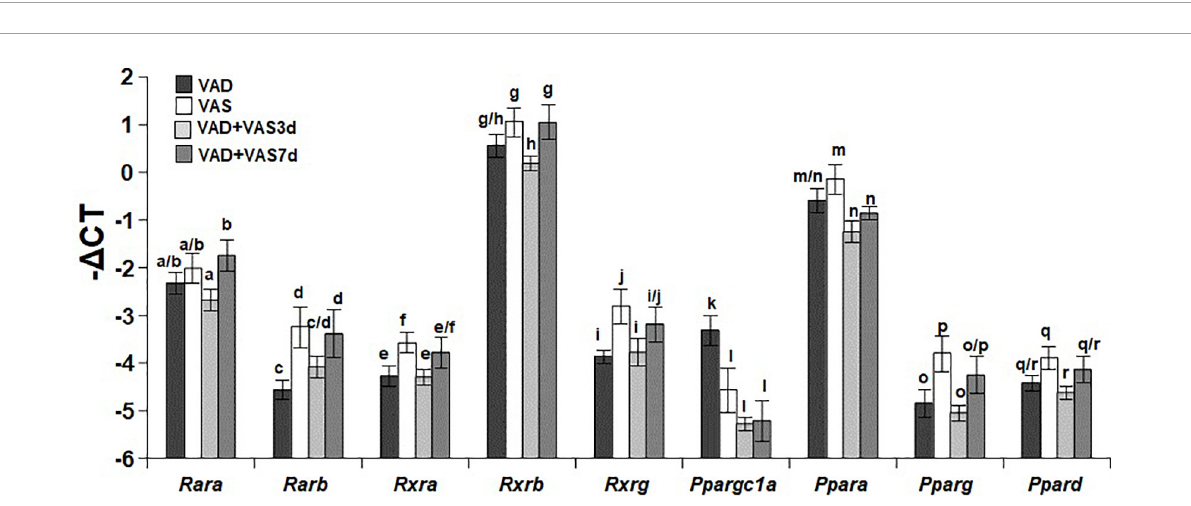
FIGURE3 The hepatic mRNA levels of Rara, Rarb, Rxra, Rxrb, Rxrg, Ppargc1a, Ppara, Pparg, and Ppard in Zucker lean (ZL) rats fed a vitamin A deficient (VAD) or vitamin A sufficient (VAS) diet for 8 weeks or fed a VAD diet for 8 weeks and fed a VAS diet for 3 (VAD + VAS 3d) or 7 (VAD + VAS 7d) days. Data are presented as mean ± SEM of minus delta Ct (cycle threshold); n = 7, 5, 5, and 5 for the VAD, VAS, VAD-VAS3d, and VAD-VAS7d, respectively; a < b for Rara (retinoic acid receptor alpha), c < d for Rarb (Retinoic acid receptor beta), e < f for Rxra (rexinoid X receptor alpha), g > h for Rxrb (rexinoid X receptor beta), i < j for Rxrg (rexinoid X receptor gamma), k > l for Ppargc1a (peroxisome proliferative activated receptor gamma coactivator 1 alpha), m > n for Ppara (peroxisome proliferative activated receptor alpha), o < p for Pparg (peroxisome proliferative activated receptor gamma), q > r for Ppard (peroxisome proliferative activated receptor delta or